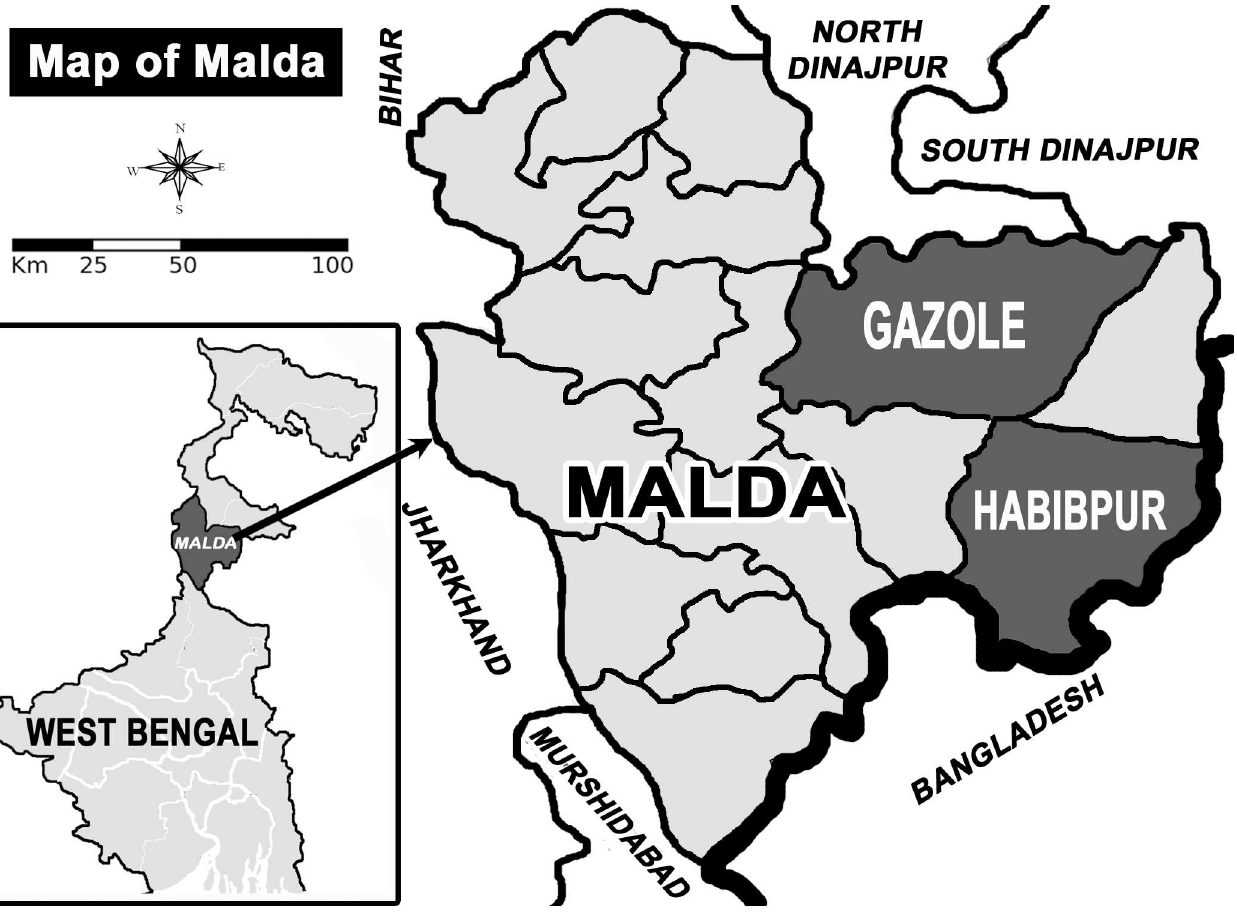
Fig 1. Map showing the study